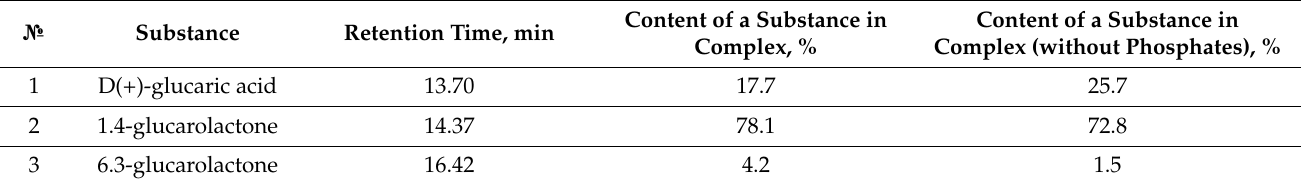
Table 4. Contents of different forms of glucaric acid in [N-VP] n -[N-VA] m [1,4- and 6,3-GL]